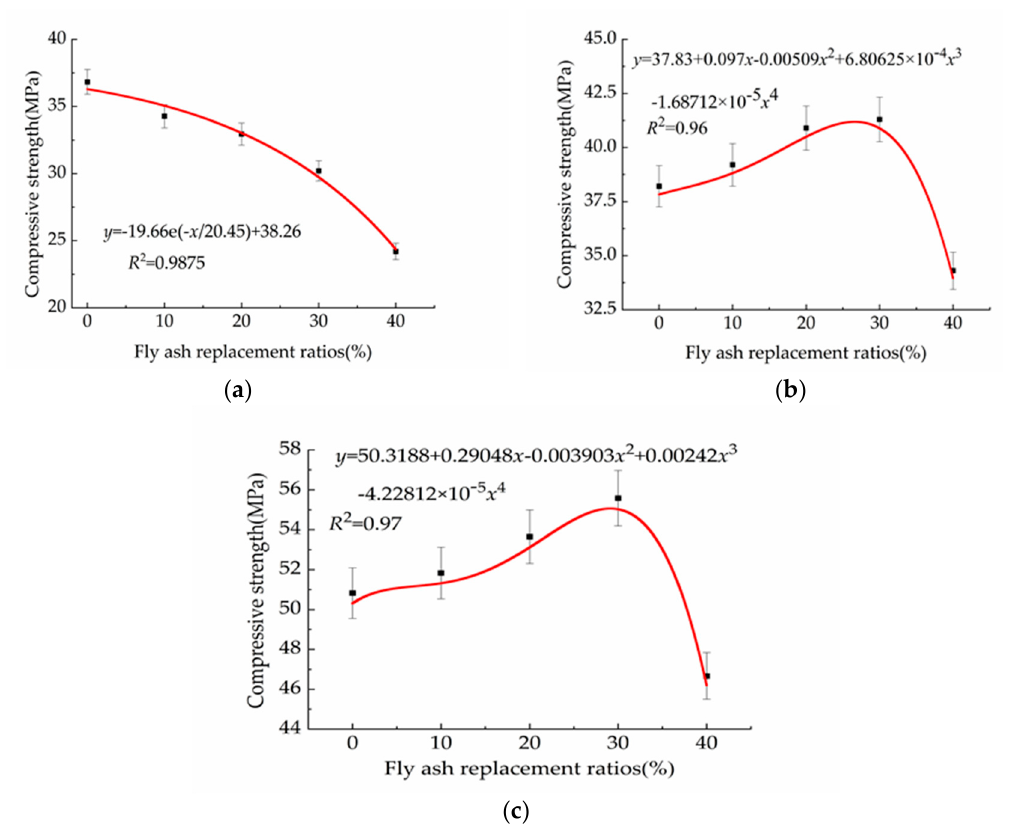
Figure 4. ( a ) Compressive strength fitting equation of 3d; ( b ) Compressive strength fitting equation of 7d; and ( c ) Compressive strength fitting equation of 28d.